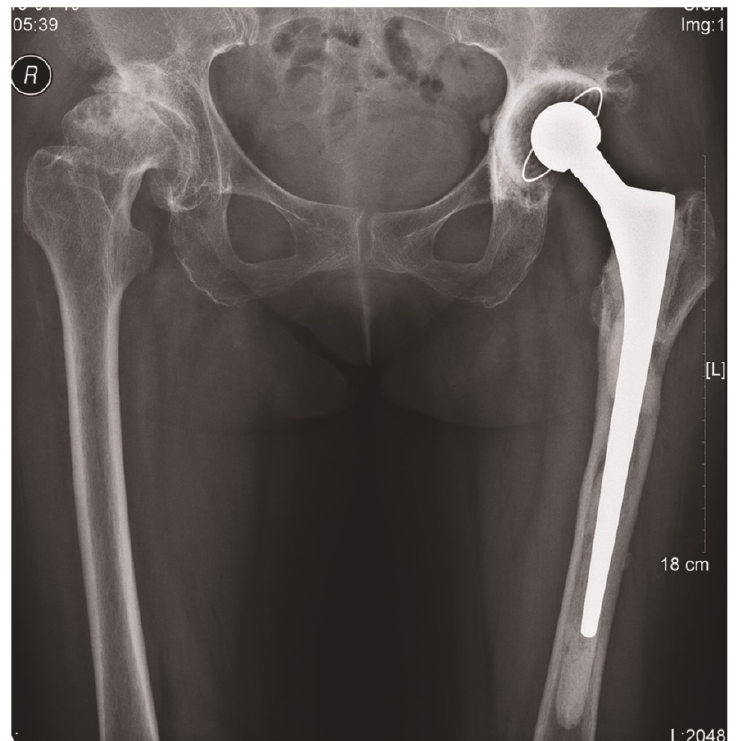
Figure 3. A set of antibiotic-loaded articulate spacers that were